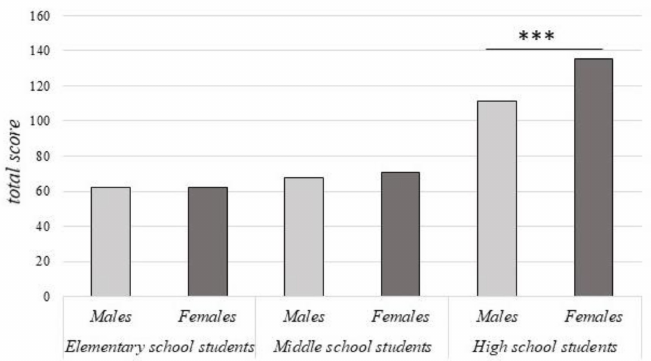
Figure 2. Gender differences in psychological distress total score among elementary, middle and high students. Significant within-group comparisons are reported. Data are presented as median. *** p < 0.001.